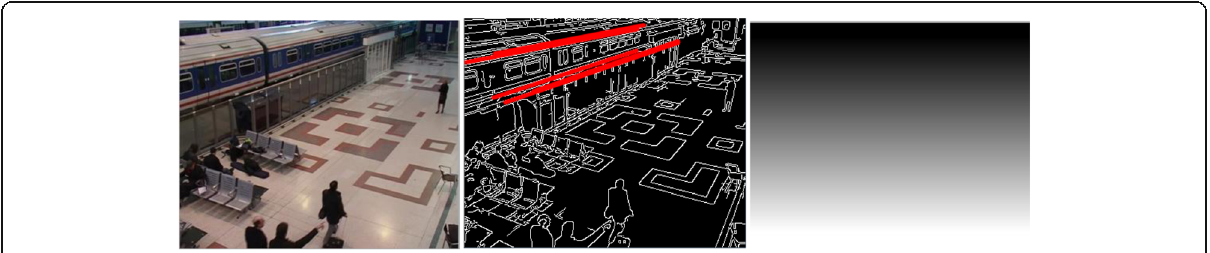
Fig. 5 Using vanishing line to decide initial map